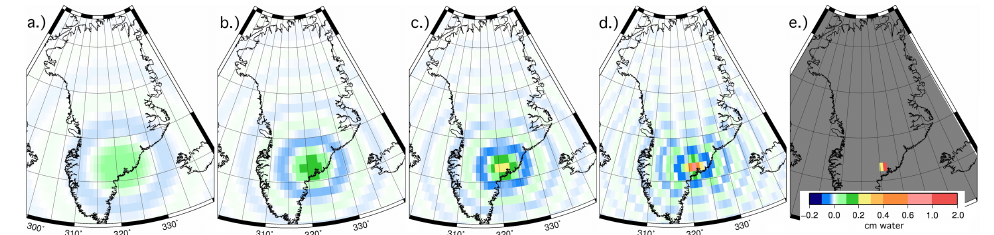
Figure 1. Impact of spatial resolution on the apparent shape and amplitude of a 1cm signal over Helheim Glacier, given the a priori weight distribution in (e) . Maximum degrees/orders are limited to (a) 60 × 60, (b) 90 × 90, (c) 120 × 120, (d) 180 × 180, and (e) the original 1 × 1 grid